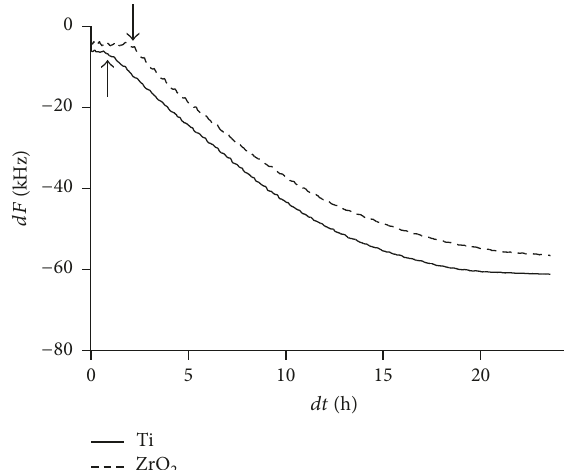
Figure2:FrequencydecreasecurvesforTiandZrO 2 sensorsinSBFsolution.Thearrowsindicateinitialstabletimebeforefrequencydecrease on each sensor.